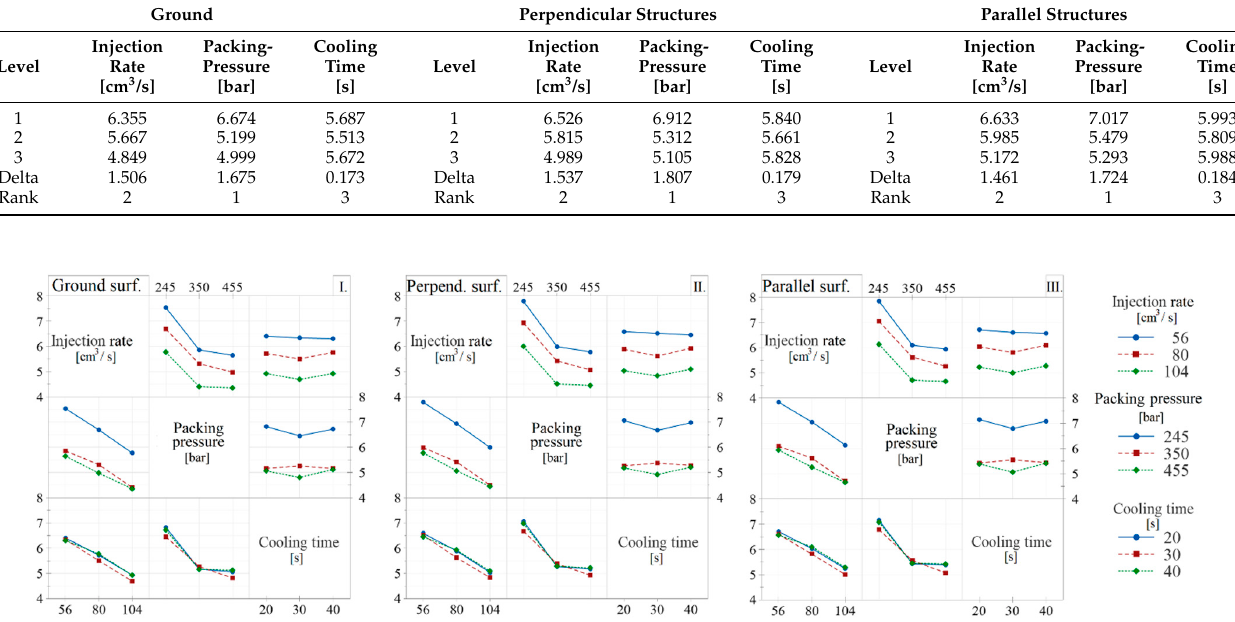
Figure 6. Interaction plot for mean graphs to investigate the effects of the technological parameters on impact strength. The left panel shows the ground (I.), the center shows the perpendicular (II.), and the right (III.) shows the specimens with parallel surface structures. Table 7. Response table of means—impact bending tests with different surface-structured specimens. Ground Perpendicular Structures Parallel Structures Injection Level